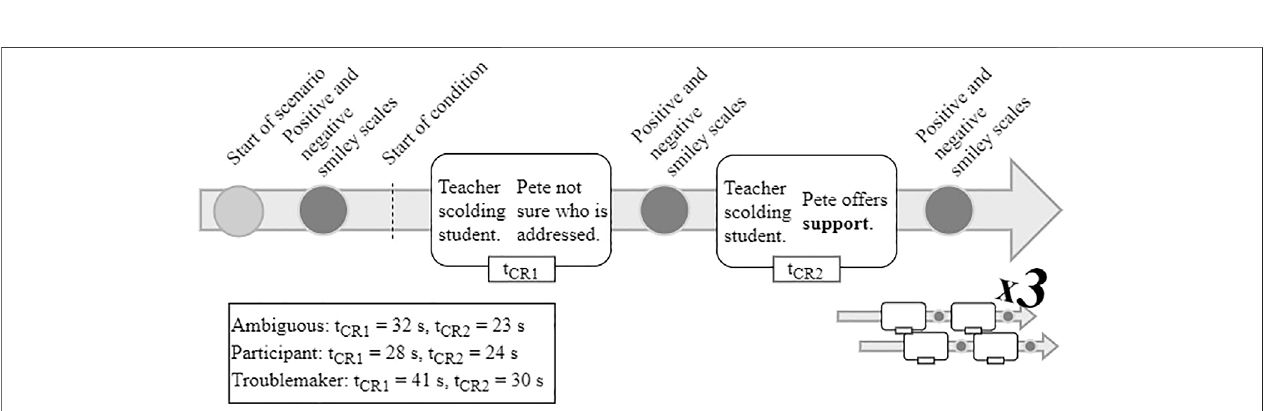
FIGURE 6 | Sequence of each condition of the Classroom scenario with the three conditions in a randomized order.